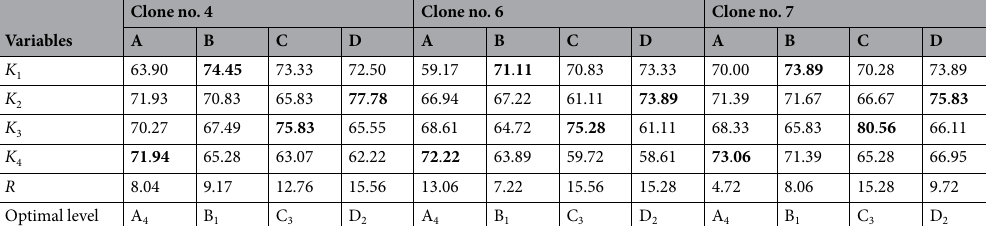
Table 2. Range analysis of L 16 (4) 4 test results for callus initiation rate. The optimal level is in bold.